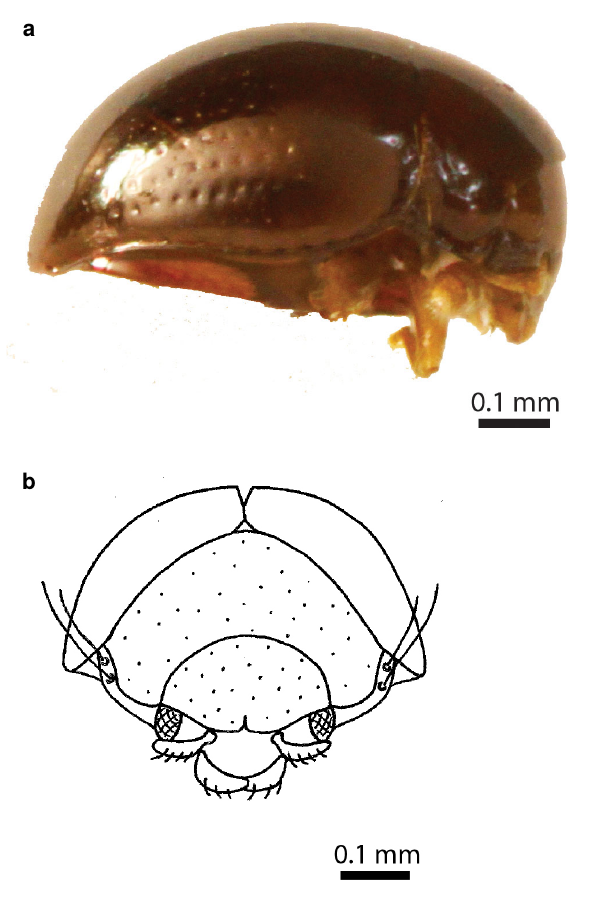
Figure 10. Clavicornaltica sabahensis sp. n., female morphology (holotype, BOR/COL/14089). a : Habitus lateral view b : Habitus frontal Hind wings : Absent. Elytra : Striae punctiform, punctures shallower dorsally, more deeply impressed laterally and becoming less visible towards the very apex. A deep but narrow punctuated groove runs along the entire margin continuing to the apex; apex itself slightly drawn out. Legs : Metafemur robust, oval, covered in fi ne white setae. Metatibia bearing eight minute setae which cover the terminal one-quarter along the external edge and one long spine, slightly shorter than the fi rst tarsomere, provided with three minute teeth (Fig. 12).